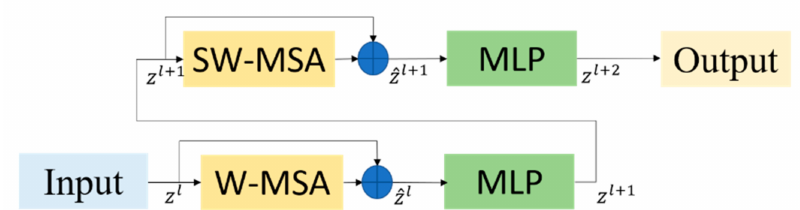
Figure 4. Modified Swin Transformer